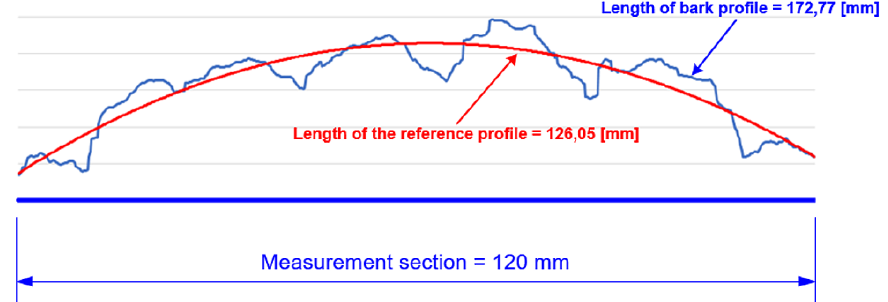
Figure 7. The third step in the analysis of the oak bark surface. It involves the determination of the reference profile, the length of the reference profile, and the length of the bark profile.